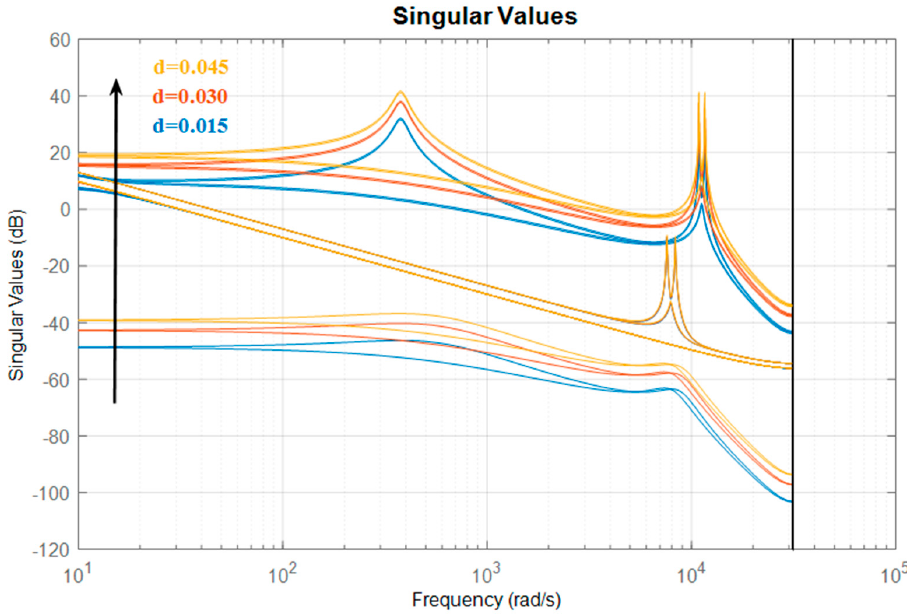
Figure 25. Singular values for multiple values of d.